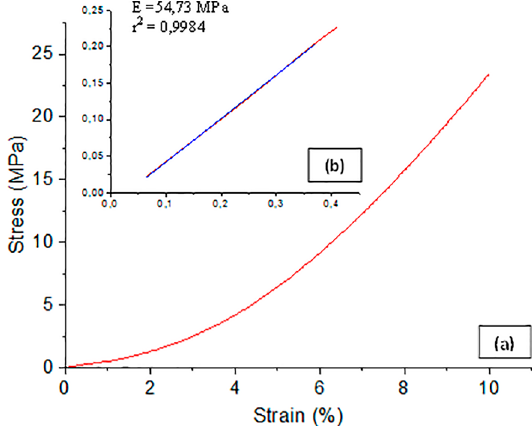
Figure 4. Voltage-strain curve for sample